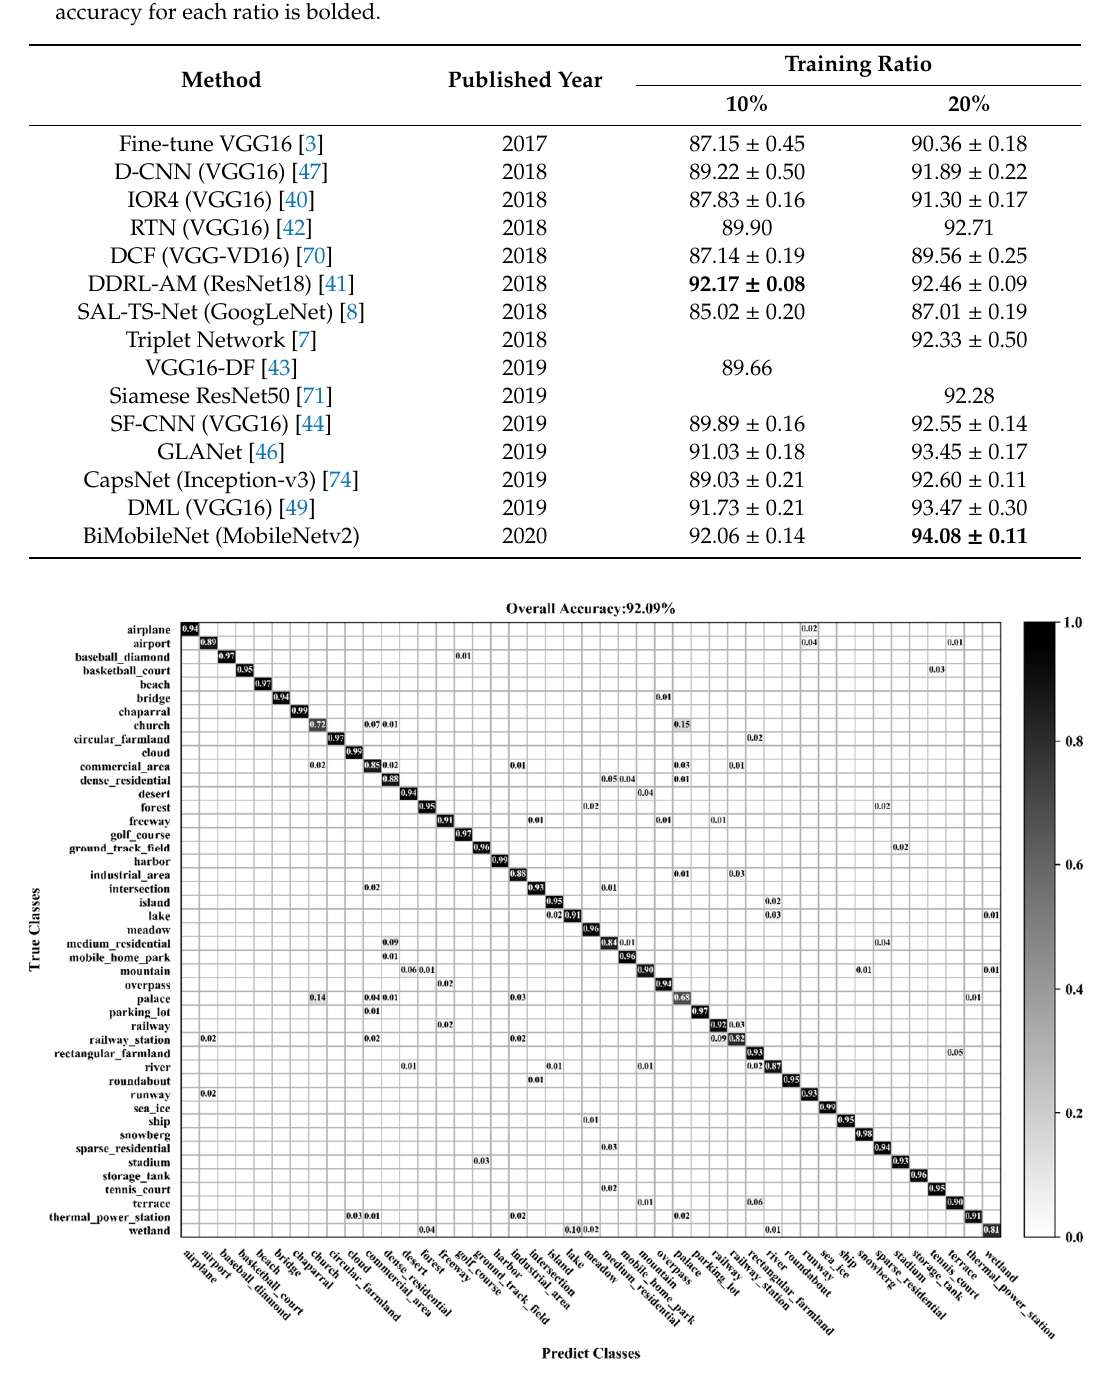
Figure 16. Confusion matrix using a training ratio of 10% on the NWPU-RESISC45 dataset.